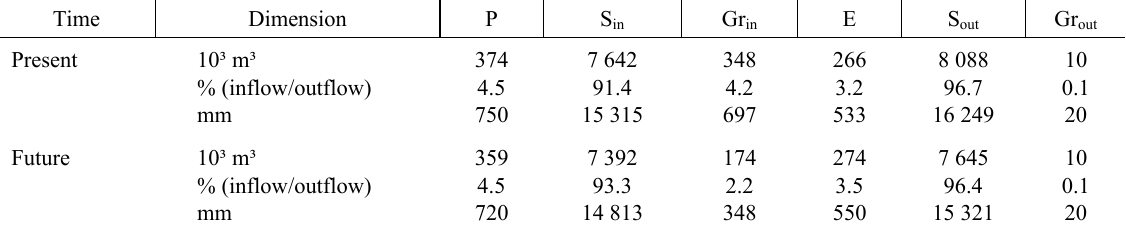
Table 1. The present (Gailiu(cid:154)is et al. 2001) and future (according to the trends of climate change) water budget of Lake Č edasas Time Dimension